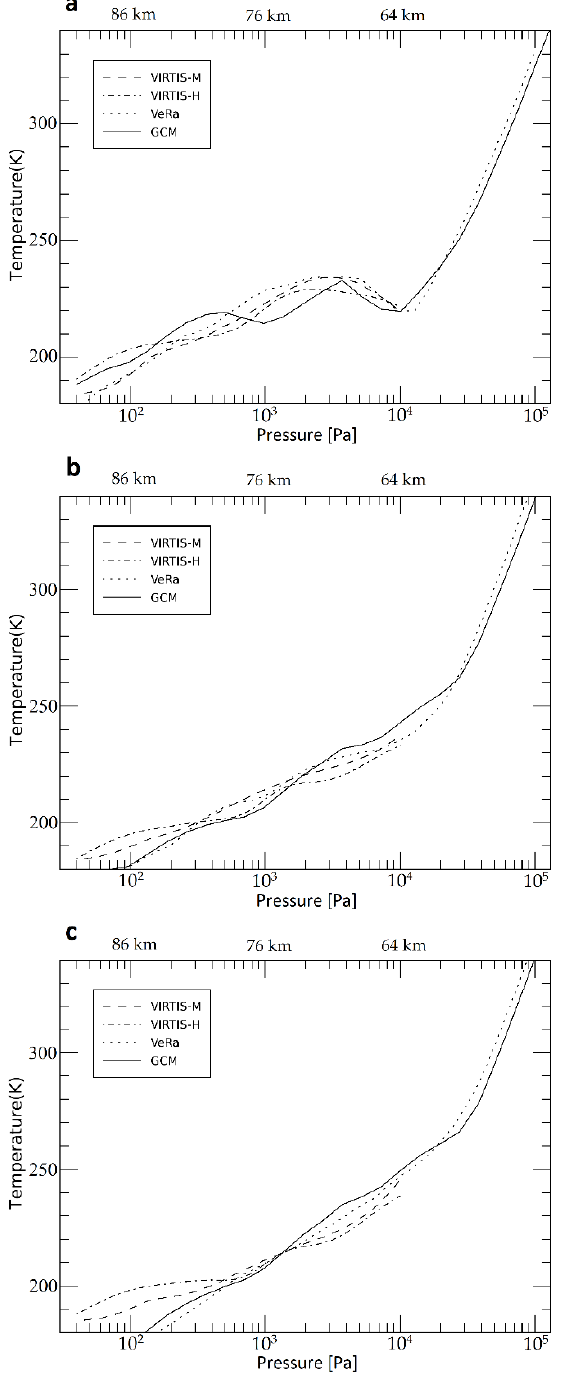
Figure 3. Average temperature profiles (K) for the IPSL Venus GCM (solid line), VIRTIS-M data (dashed line), VIRTIS-H data (dotted-dashed line) and VeRa data (dotted line), at: ( a ) −75°; ( b ) −45°; ( c ) −15°. The average has been obtained over 360° of longitude and the entire night.